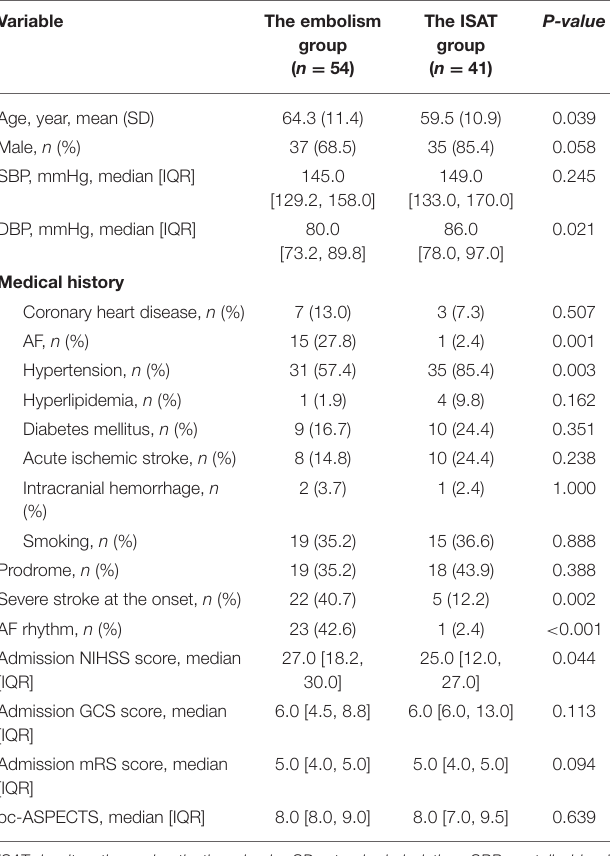
TABLE 2 | Comparisons of laboratory tests between the in situ atherosclerotic thrombosis group and the embolism group. Variable The embolism The ISAT group group ( n = 54) ( n = 41)